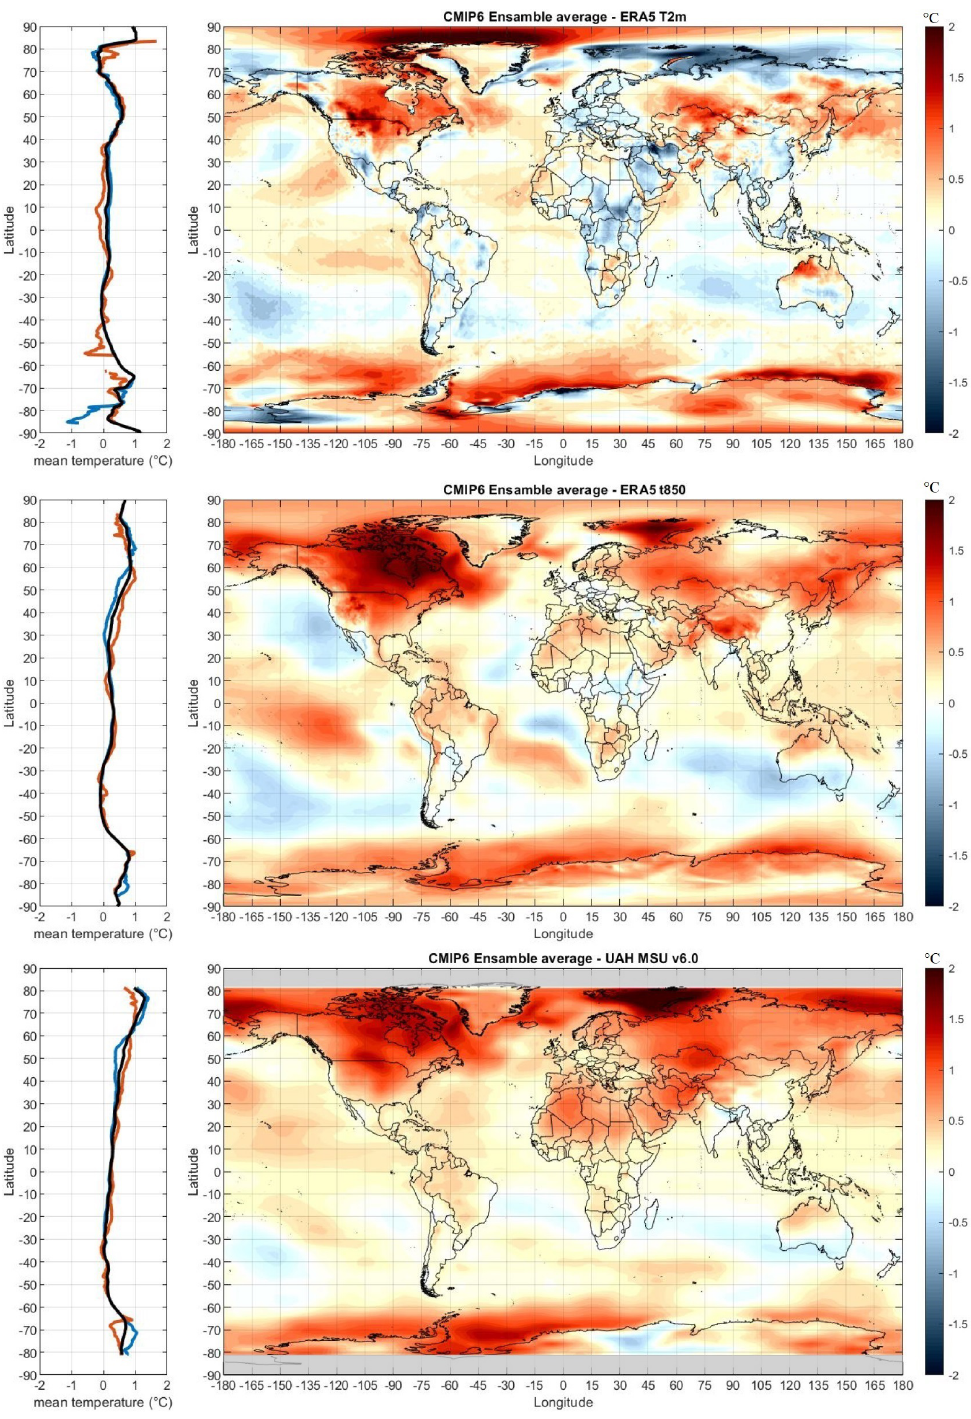
Figure 5. Difference between the warming from 1980–1990 to 2011–2021 predicted by the CMIP6- tas ensemble average record and those produced by the three temperature records ERA5-T2m, ERA5-850mb and UAH MSU v6.0